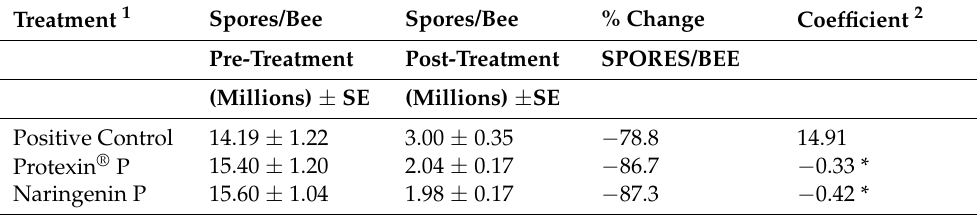
Table 6. Effect of spring 2018 treatments on N. ceranae spore counts per bee one–two days pre- treatment and three weeks post-treatment with the prebiotic naringenin or probiotic Protexin ® . Coefficients indicate how the log of spores per bee changed relative to the positive control. Means are from 100 bees in 33–34 colonies per treatment.